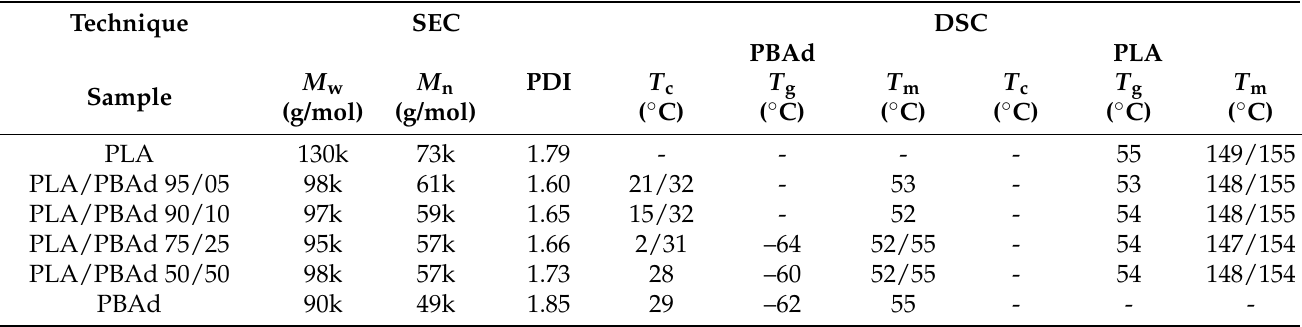
Table 1. Values of interest for the synthesized copolymers: molecular weight values, weight averaged (M w ) and num- ber averaged (M n ), and polydispersity index (PDI), estimated by SEC, and crystallization, melting and glass transition temperatures (T c , T m and T g accordingly), estimated by